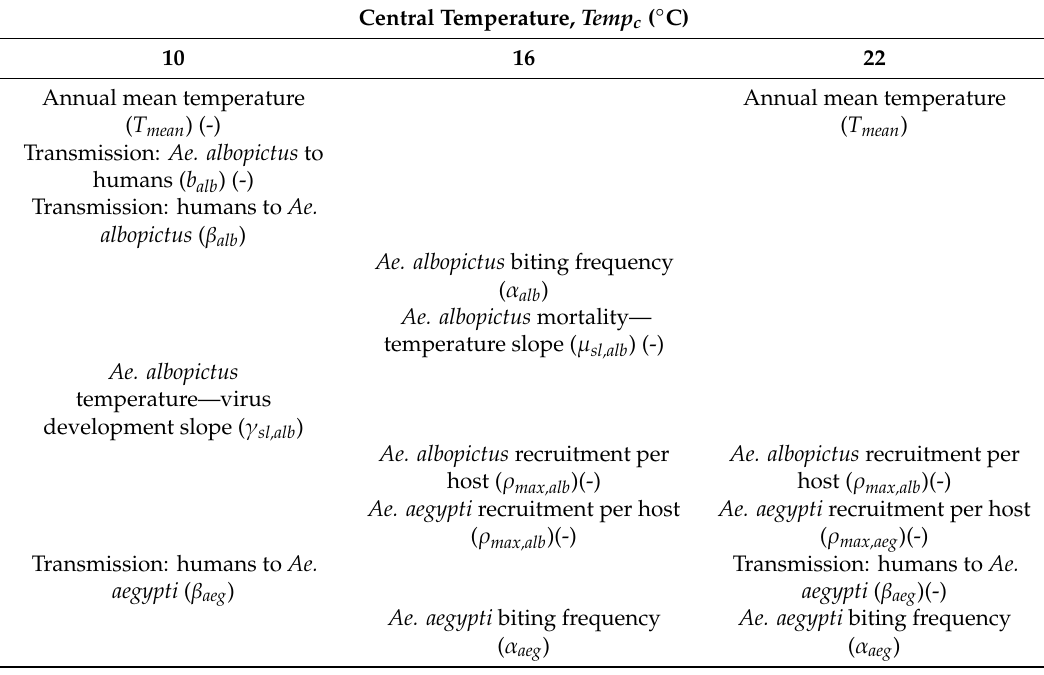
Table 5. Top five parameters influencing lag . Includes only epidemic simulations, main e ff ects